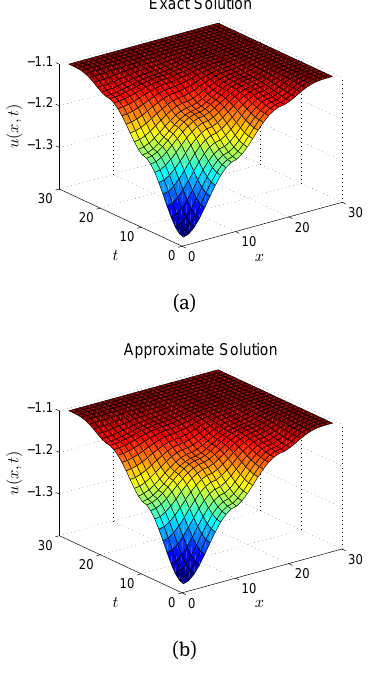
Figure 13: Space-time graph of the exact solution and approximate solution for example